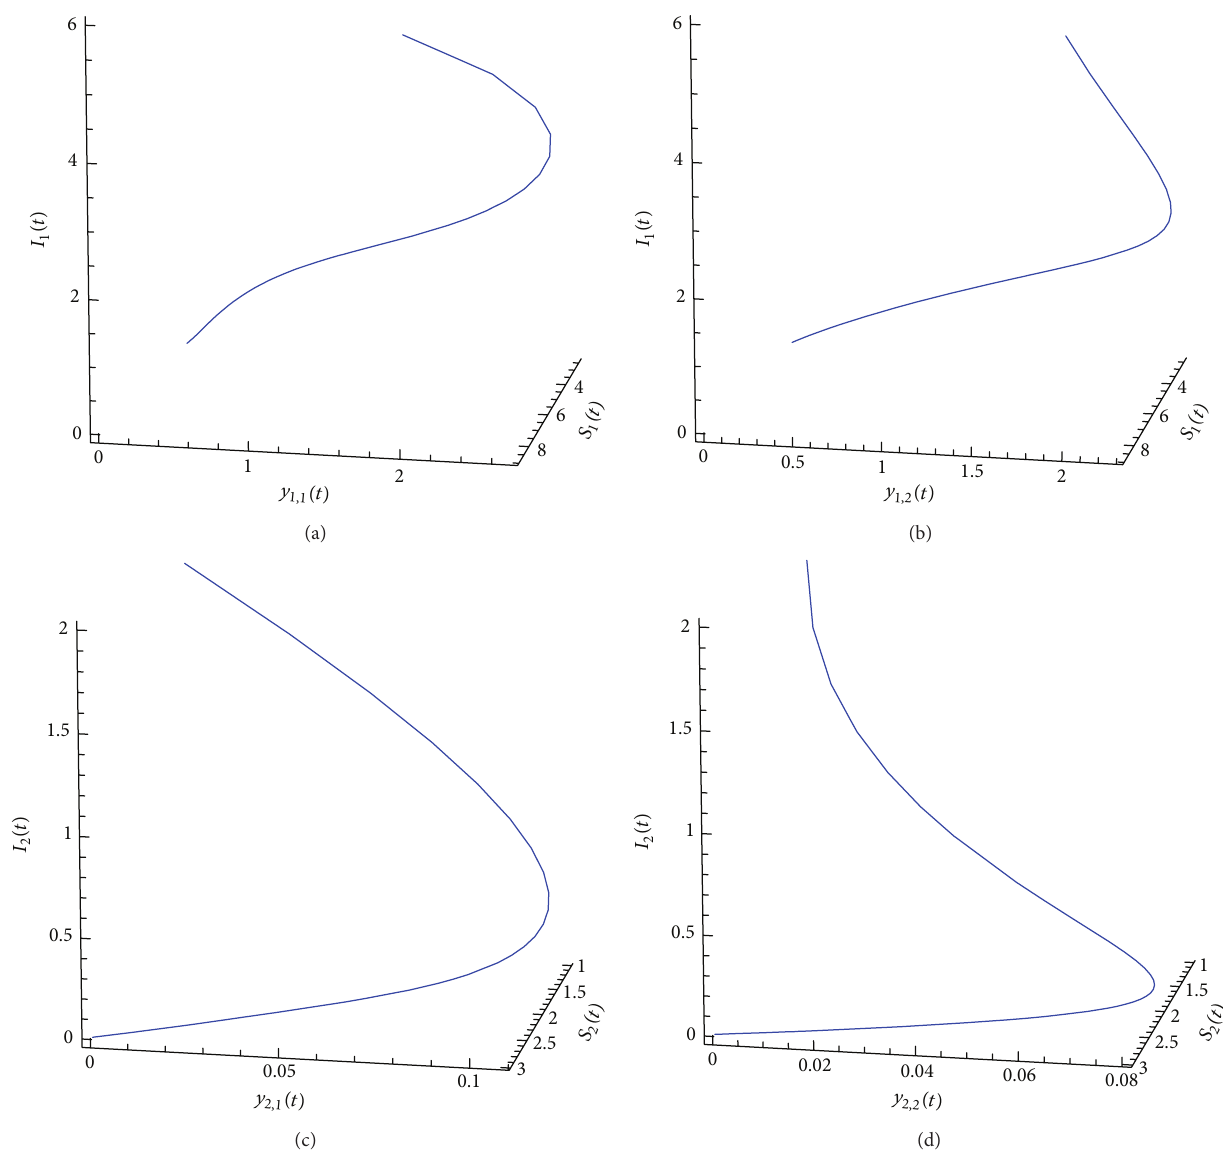
Figure 2: Numerical simulation of (45) with 𝑅 0 = 0.051 < 1 ; hence 𝑃 0 = (3,0, 0, 0,3, 0, 0, 0) is globally stable. Graphs (a) and (b) illustrate that 𝑆 1 ( t ),𝑦 1,1 (𝑡),𝑦 1,2 (𝑡) and 𝐼 1 (𝑡) will eventually towards to steady state. Graphs (c) and (d) illustrate that 𝑆 2 (𝑡),𝑦 2,1 (𝑡),𝑦 2,2 (𝑡) , and 𝐼 2 (𝑡) will eventually towards to steady state. Initial values are 𝑆 1 (0) = 9, 𝑆 2 (0) = 1, 𝑦 1,1 (0) = 2, 𝑦 1,2 (0) = 2,𝑦 2,1 (0) = 0,𝑦 2,2 (0) = 0, 𝐼 1 (0) = 6 , and (0) = 2 𝐼 2